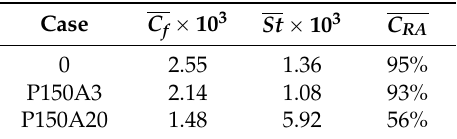
Figure 18. Temporal evolution of C RA for Case P150A20. Table 3. Mean values of skin friction, Stanton number and their correlation. Table 3. Mean values of skin friction, Stanton number and their correlation.